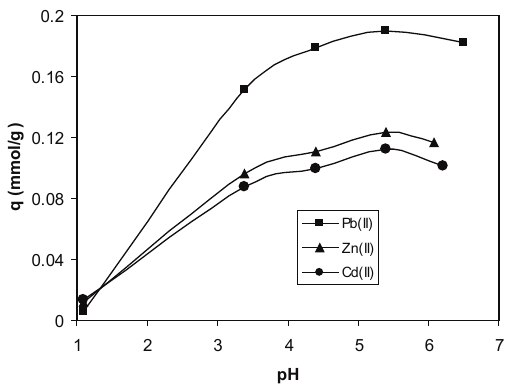
Figure 2 : Effect of initial solution pH on the biosorption of heavy metals onto mustard waste biomass (biosorbent dose = 5